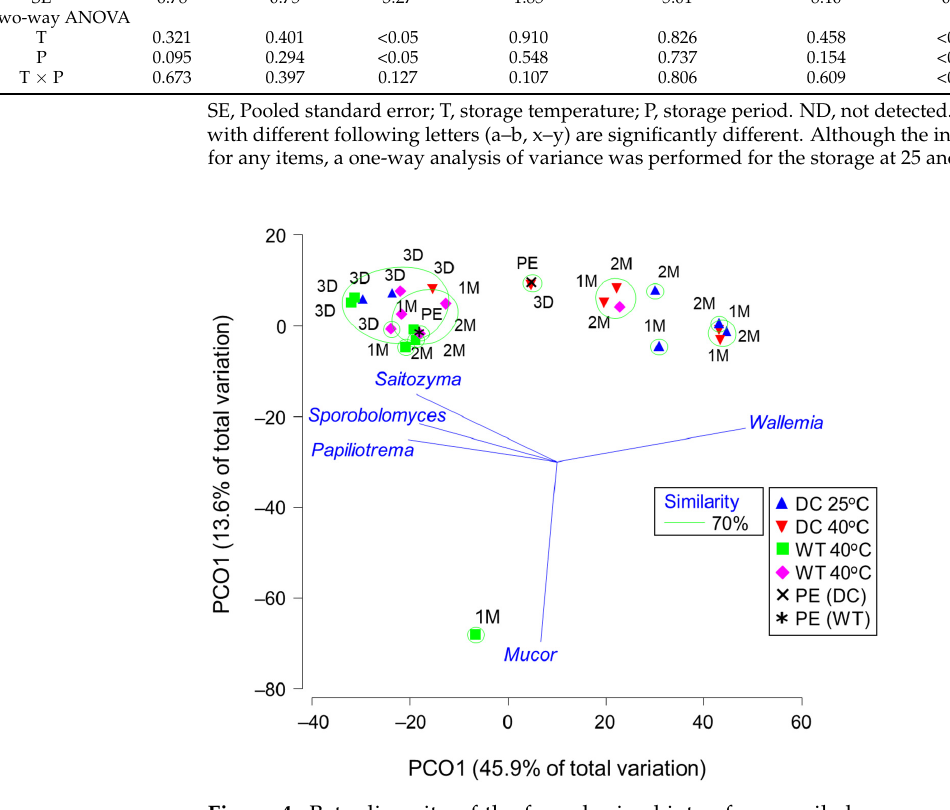
Figure 4. Beta diversity of the fungal microbiota of pre-ensiled crops and silages prepared from direct-cut and wilted guinea grass. The principal coordinate analysis plot of the Bray-Curtis distance matrix was generated from the filtered genus (relative abundance >1%). Points that are closer together on the ordination have a more similar microbiota. The operational taxonomy unit with a Pearson’s correlation of >0.7 is overlaid on the plot as vectors. Green circles denote samples enclosed in the same group at a 70% similarity level. PE, DC, WT, 3D, 1M, and 2M indicate pre-ensiled crop, direct-cut silage, wilted silage, silage stored for 3 days, silage stored for 1 month, and silage stored for 2 months, respectively.